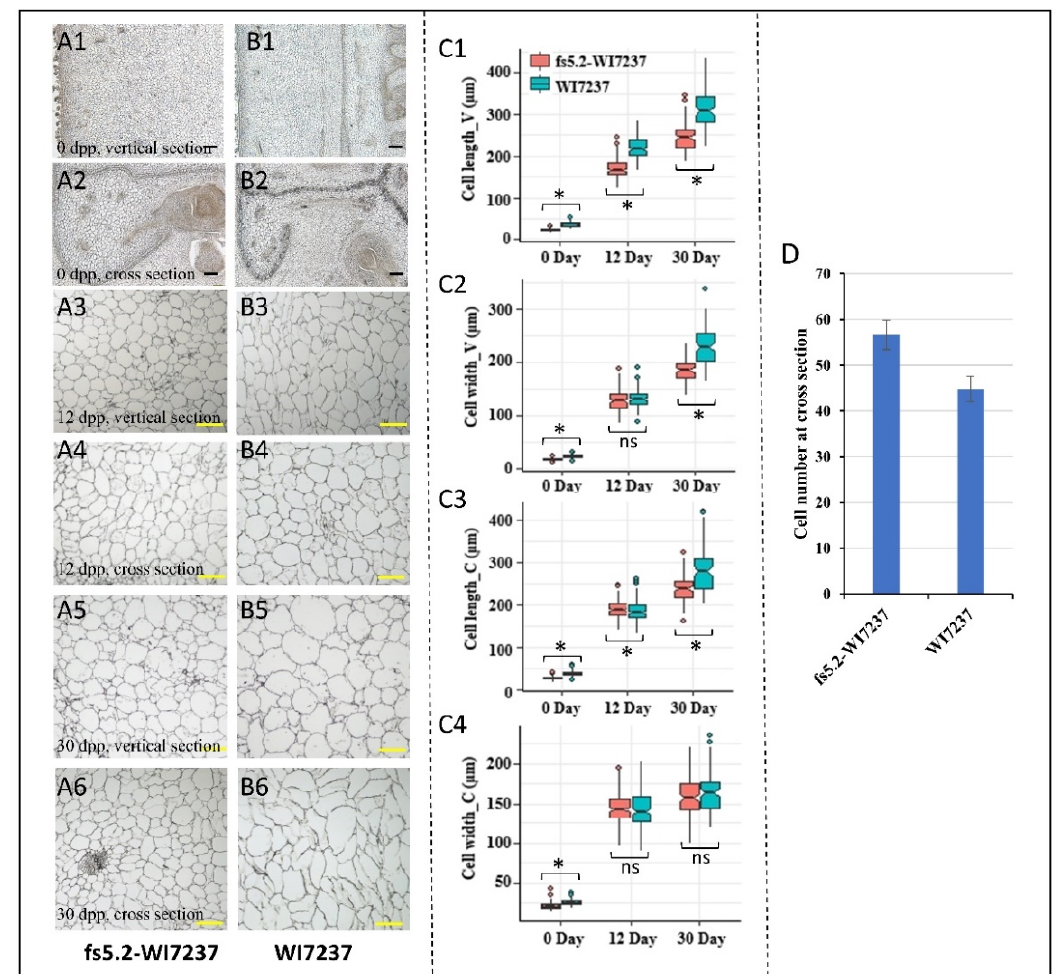
Figure 3. Microscopic images of longitudinal sections (1, 3, and 5) or cross-sections (2, 4, and 6) of ovary/fruit of fs5.2-WI7237 ( A1 – A6 ) and WI7237 ( B1 – B6 ) at different stages. Black bar = 100 μ m; yellow bar = 200 μ m. ( C ) Cell length and width of vertical sections (V) and cross-sections (C) of WI7237 and fs5.2-WI7237 ovary/fruit at different development stages. * means significantly different at P < 0.01; ns = no significant difference. ( D ) Cell numbers (layers) at cross-section of WI7237 and fs5.2-WI7237 ovary at 0 dpp.